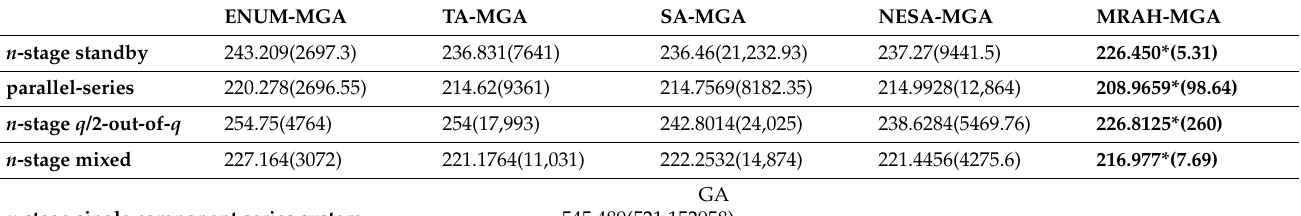
Table 45. The optimal total system cost and CPU running time based on four system configurations and five combined